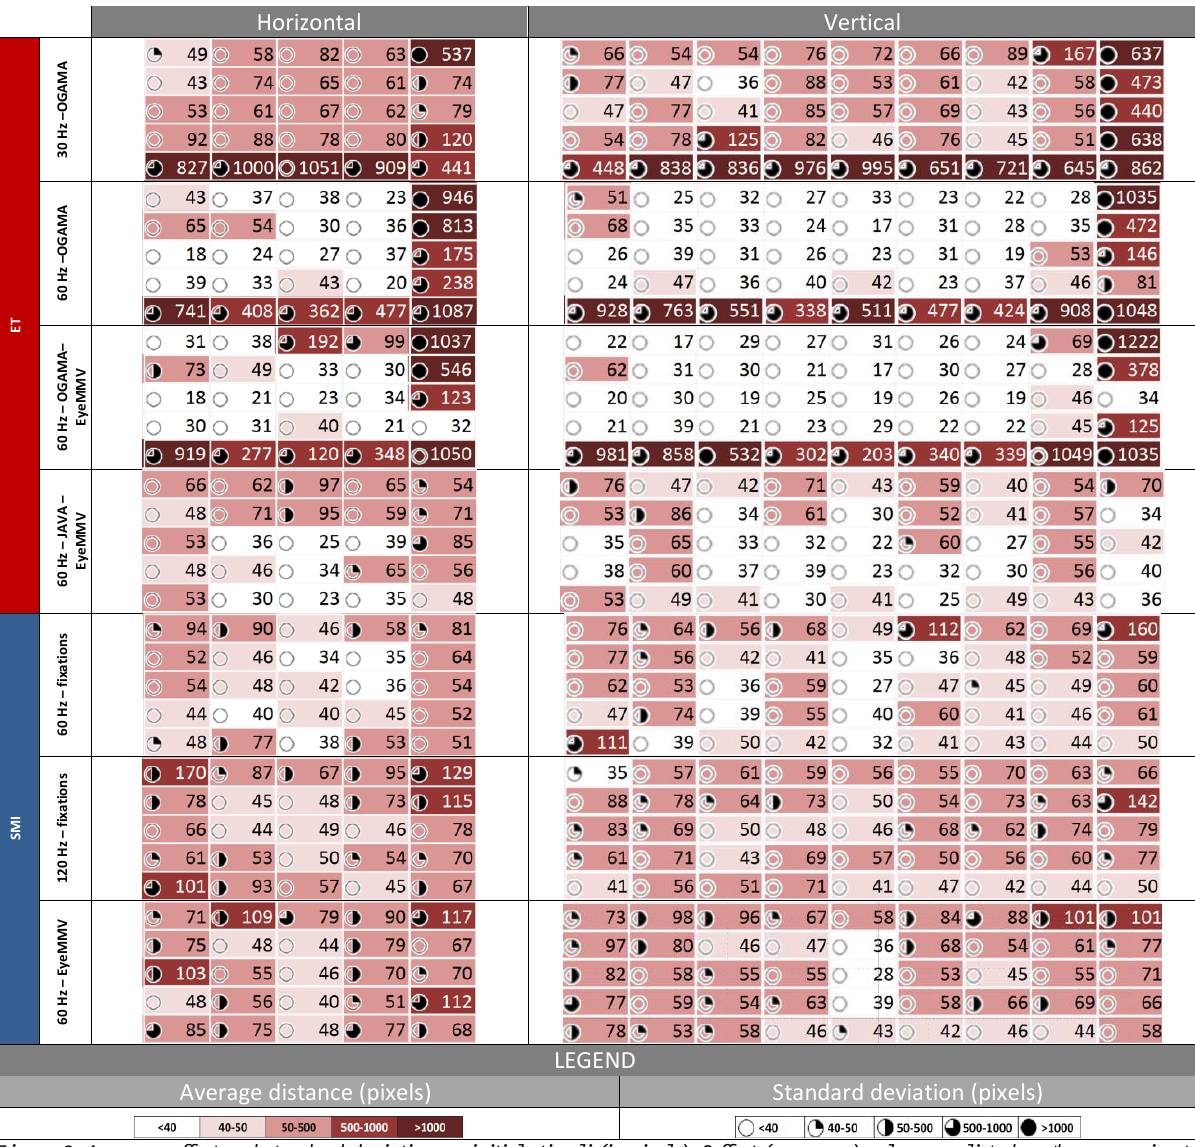
Figure 6: Average offset and standard deviation on initial stimuli (in pixels). Offset (accuracy) values are listed on the approximate corresponding positon on the screen in a tabular layout. The color of the cells is linked to the offset value, categorized in five steps. The standard deviation (precision) is visualized using a pie chart that is added to the corresponding cell, also using the same five